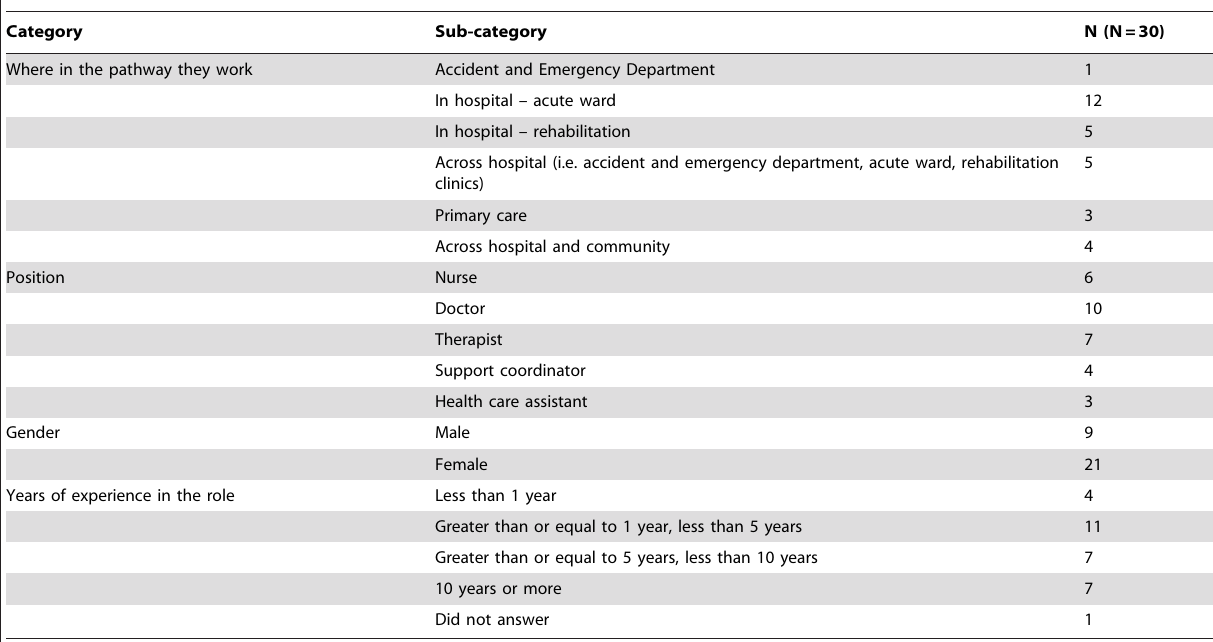
Table 1. Characteristics of